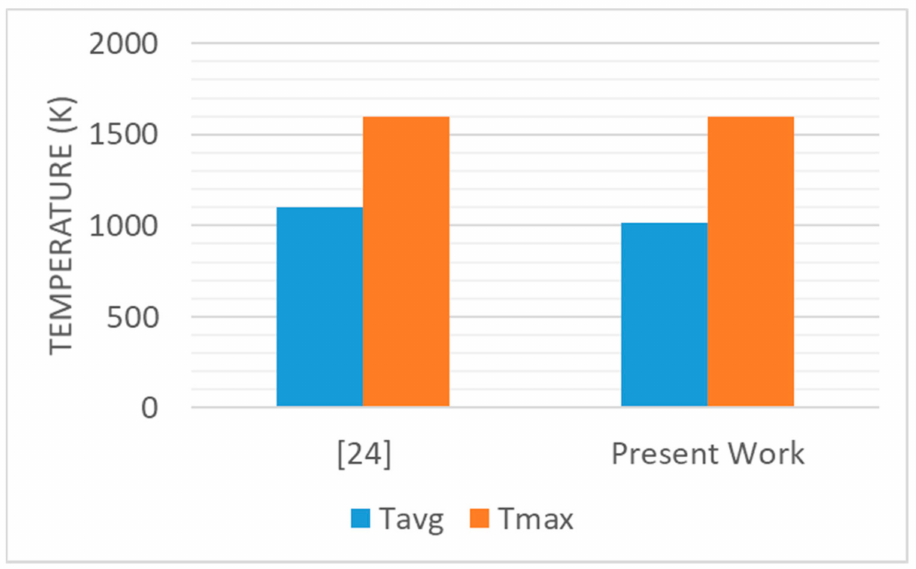
Figure 13. Comparison between present model (case II) and the data obtained from